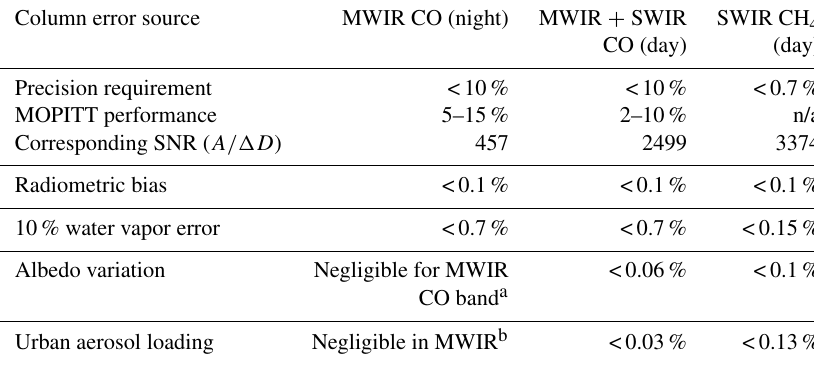
Table 2. Expected precision and accuracy for